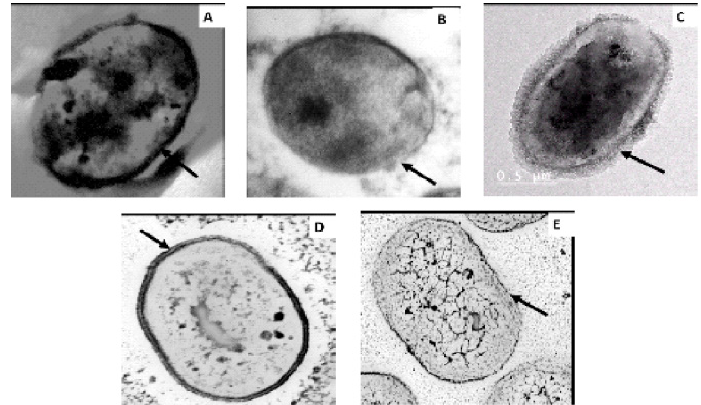
Figure 1. Transmission electron micrographs of thin sections of colistin-sensitive and -resistant A. baumannii strains. ( A ) Colistin-sensitive strain MS48, displaying a thick cell membrane. ( B ) MS48 after the acquisition of colistin resistance, displaying a thin cell membrane. ( C ) Clinical colistin-resistant strain MS34, displaying a thin cell membrane and a glycocalyx. ( D ) Clinical colistin-sensitive strain MS64, displaying a thick cell membrane. ( E ) MS64 after the acquisition of colistin resistance, displaying a thin cell membrane.